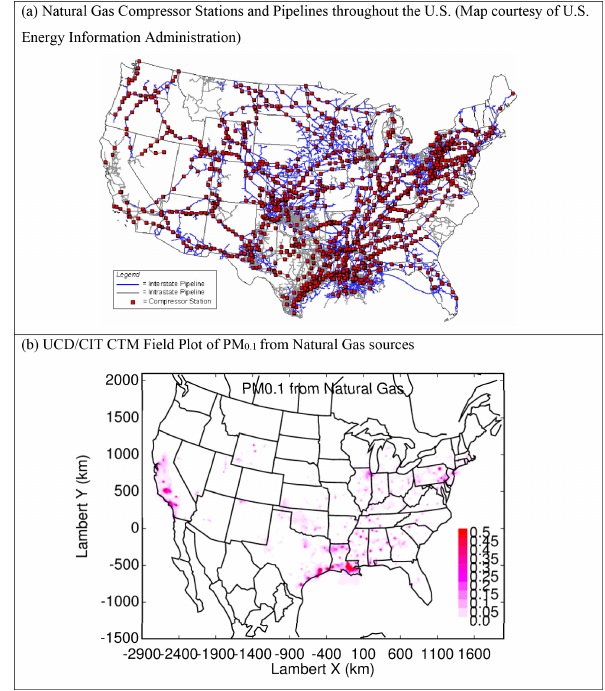
Figure 9. (a) Natural gas compressor stations and pipelines across the US and (b) PM 0 . 1 natural gas combustion concentrations (µgm − 3 ).